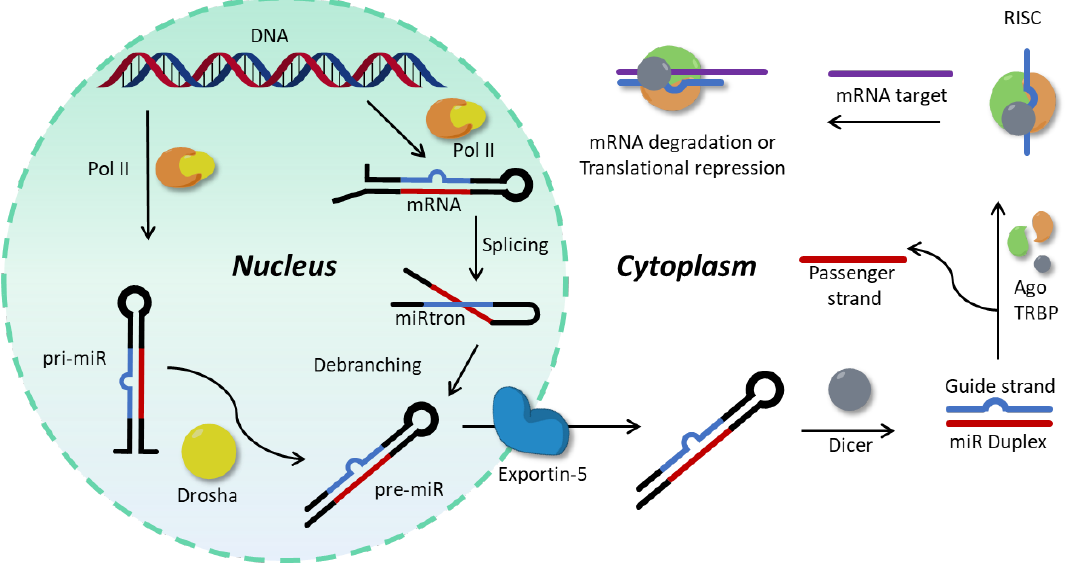
Figure 1. Schematic representation of the principal biogenetic pathways of microRNA (miR) formation and activity.